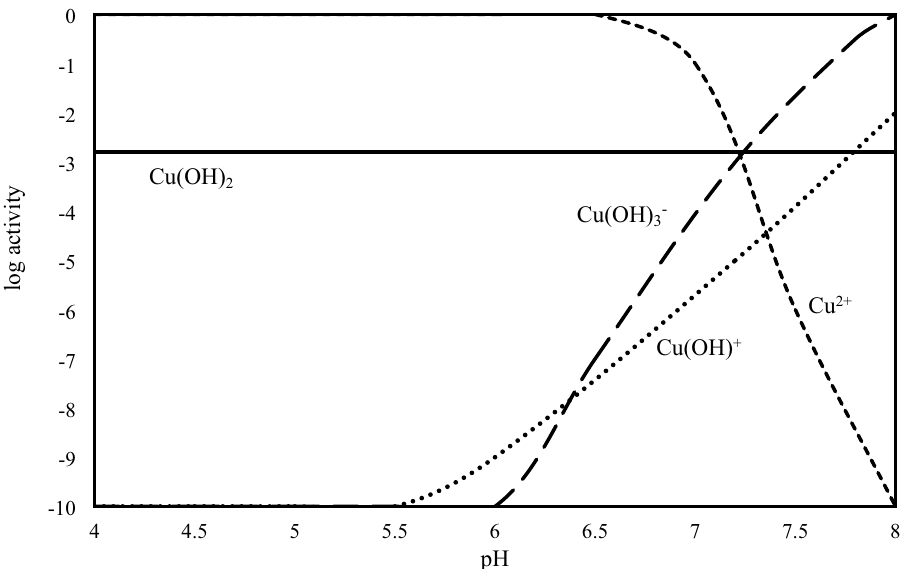
Figure 5. The pa-pH diagram for cupric solubility in the equilibrium solution using visual MINTEQ (ionic strength 0.01 M CaCl 2 ).